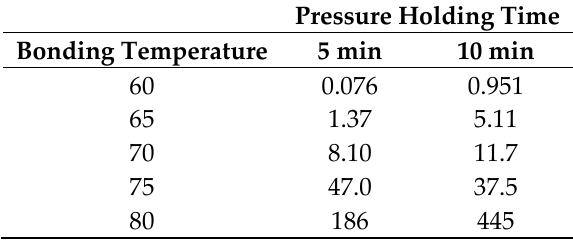
Table 1. Bond strength in J/m 2 (Median, N = 10) for different bonding temperatures and pressure holding times.